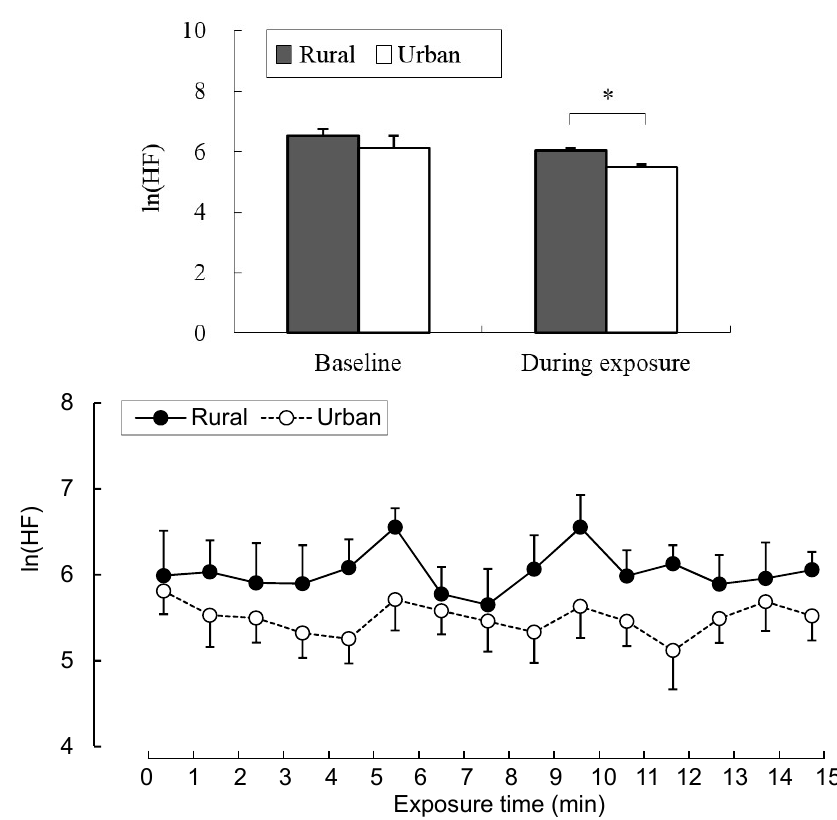
Figure 4. Comparison of the natural logarithm of the high frequency value in heart rate variability between rural and urban exposures (top) and of the 1-min fluctuations of the values (bottom) during exposure. Mean ± SE; N = 11; * p < 0.05; paired t